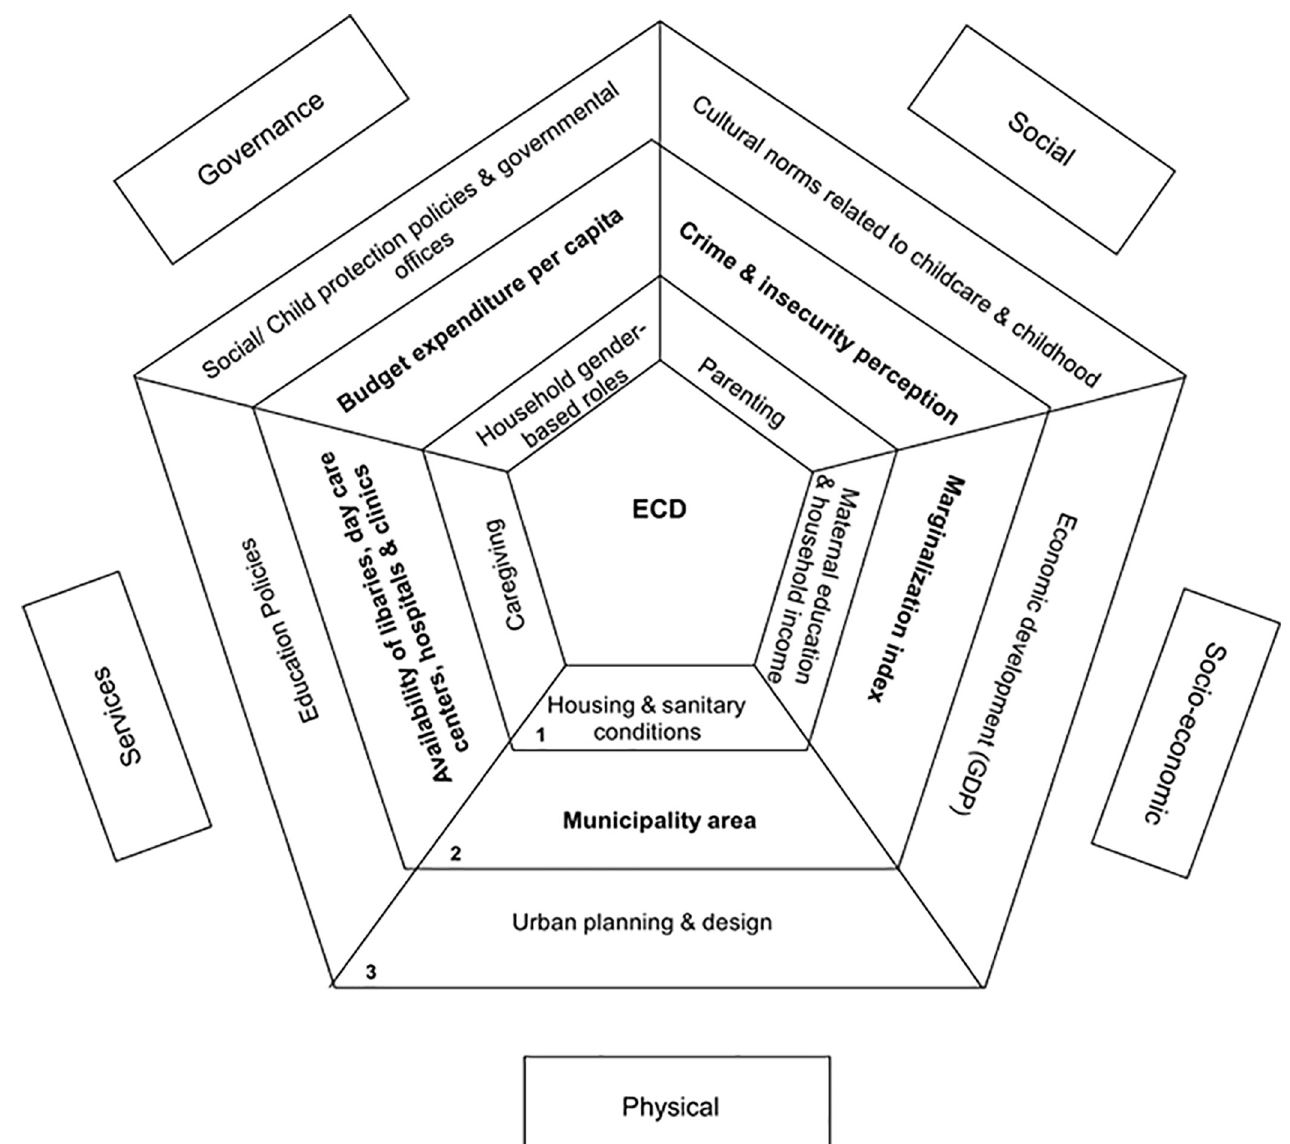
Fig 1. Conceptual model for the influence of neighborhood characteristics over early childhood development. (A) Outside boxes (and area below them) correspond to the environmental domains described by Goldfeld et al. Each domain encompasses variables at different levels represented by rows of the pentagon: 1 = household; 2 = municipality; 3 = country/structural context and corresponding measures influencing early child development (ECD). Bolded variables are the ones included in our study, aimed at assessing municipality features that could be associated with ECD. (B) Domains and levels are interconnected and influence overall ECD. For example, under governance domain, policies related to social protection could influence the way budget is spent at national and municipal level (proxied by budget per capita in our study). The way expenditures are assigned to women and children through social protection programs could influence women’s ability to decide household expenditures (household gender-based roles) and have agency on caregiving and parenting which could impact on child development through proper child stimulation by early schooling or at-home reading and playing.